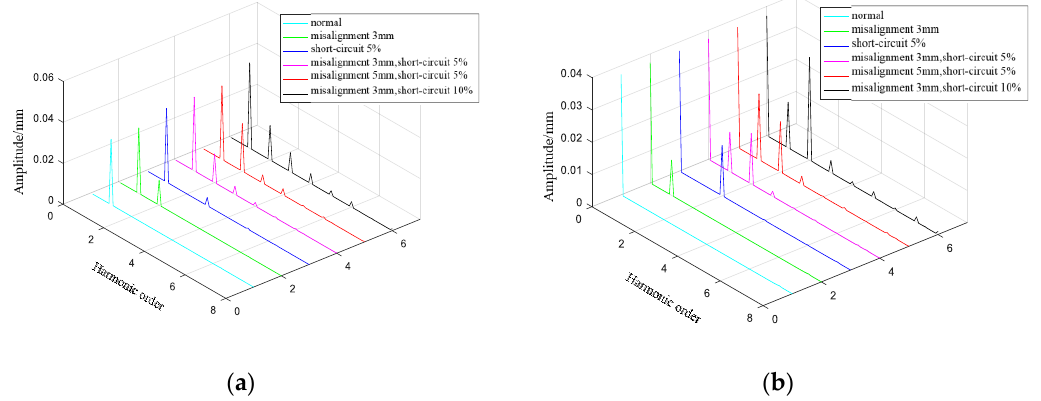
Figure 16. Vibration response frequency waterfall diagram with coupling fault: ( a ) Radial vibration; ( b ) Torsional vibration.